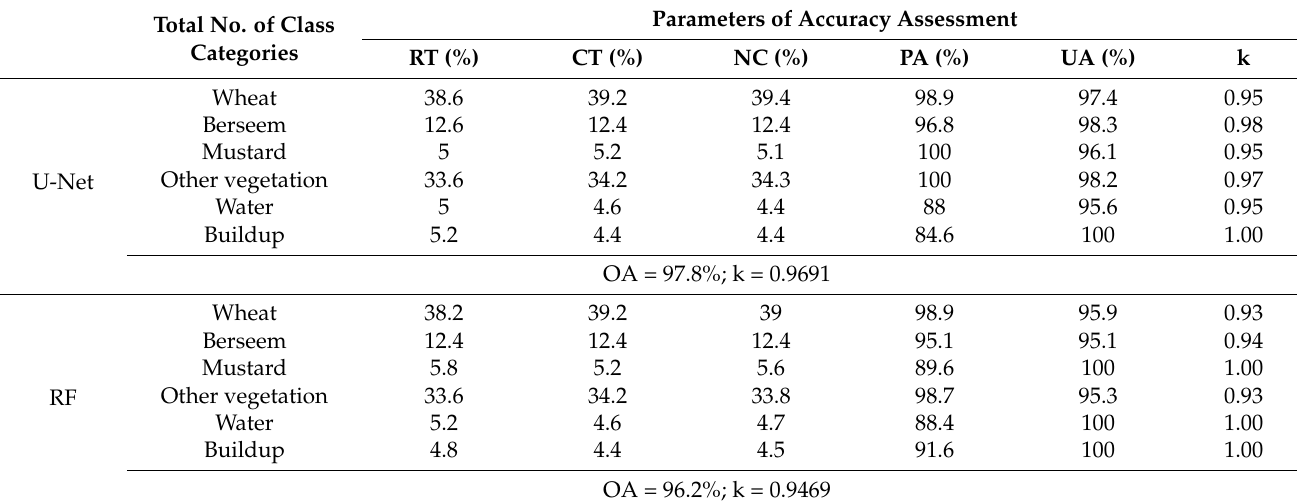
Table 2. Accuracy assessment computed from U-Net and RF classification